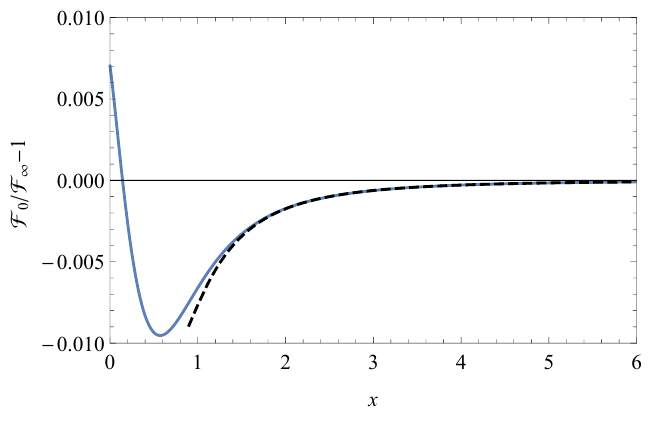
/ F ∞ from unity as obtained from 0